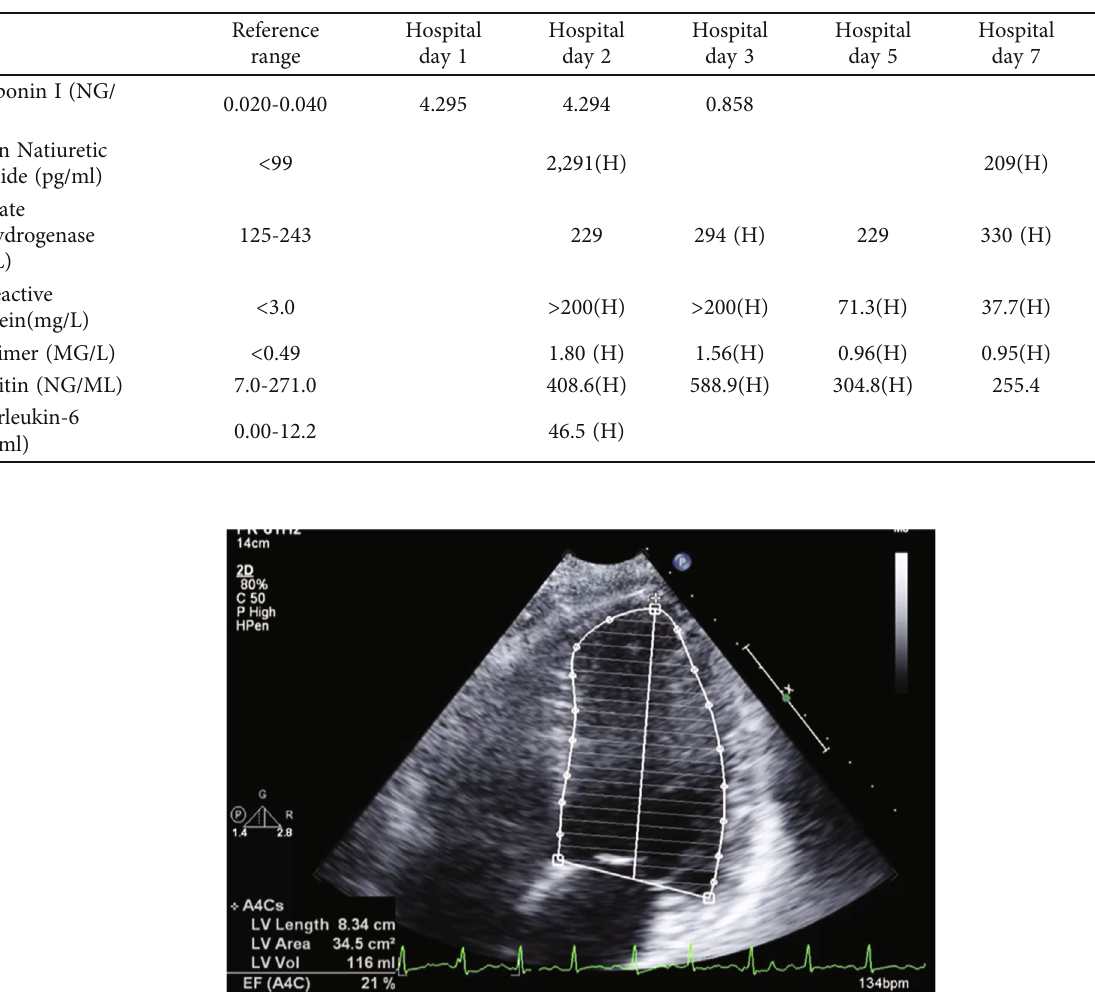
Figure 2: Simpson ’ s method of disc ’ s for measuring ejection fraction at the end of systole on